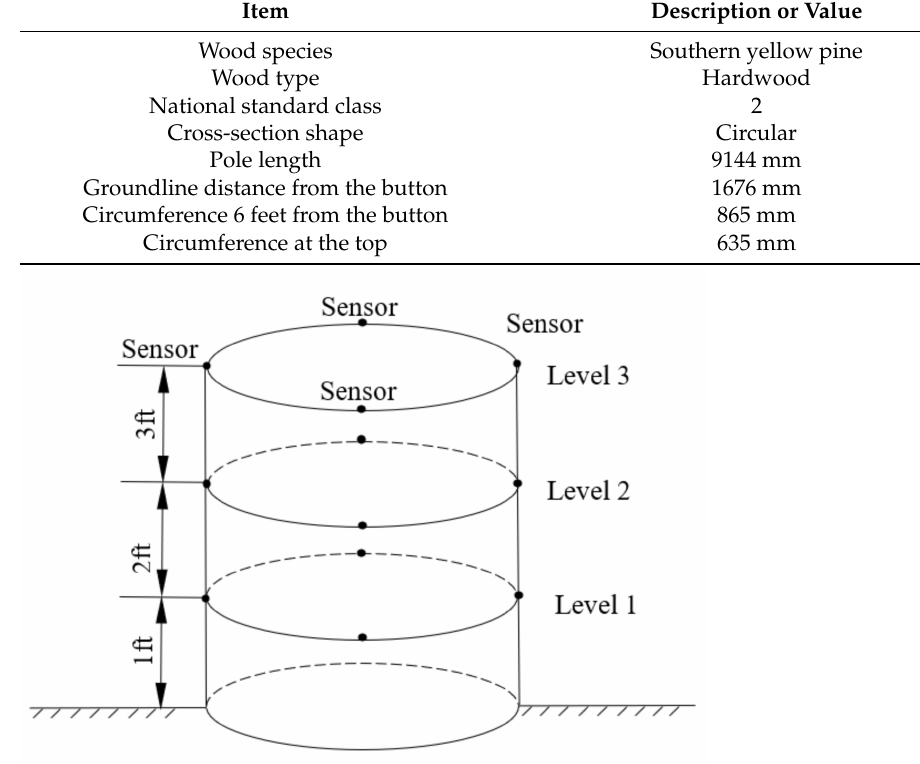
Figure 4. Measurement point assignments of each wooden utility